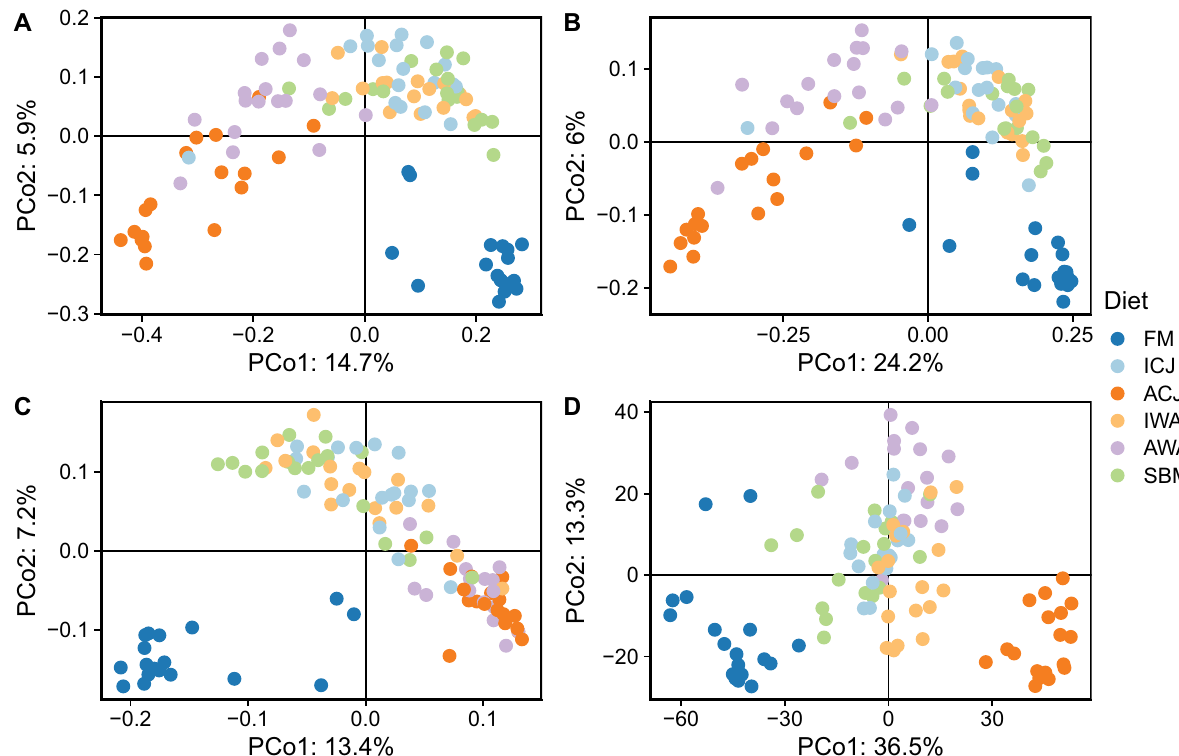
Fig. 6 Principal coordinates (PCo) analysis plots of beta-diversity of gut microbiota of fish fed the experimental diets. The four beta-diversity indices used are; ( A ) Jaccard distance, ( B ) Unweighted Unifrac distance ( C ) Aitchison distance and ( D ) PhILR transformed Euclidean distance. The samples